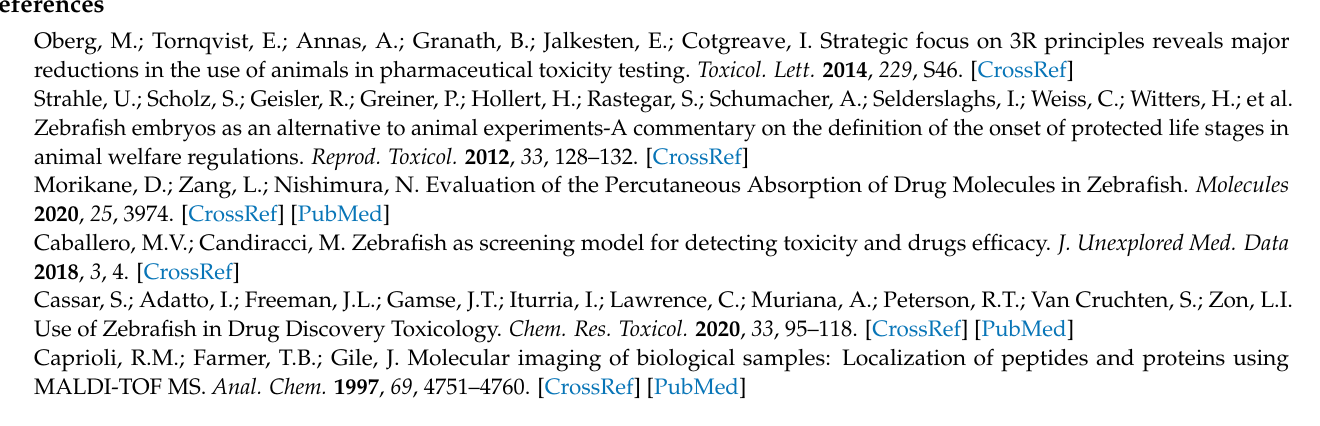
Figure S2: Mass spectrometry imaging of a zebrafish larva section in m / z range 500–1300; Figure S3: MALDI spectrum of clozapine in dosed zebrafish larva; Figure S4: DESI spectrum of clozapine in dosed zebrafish